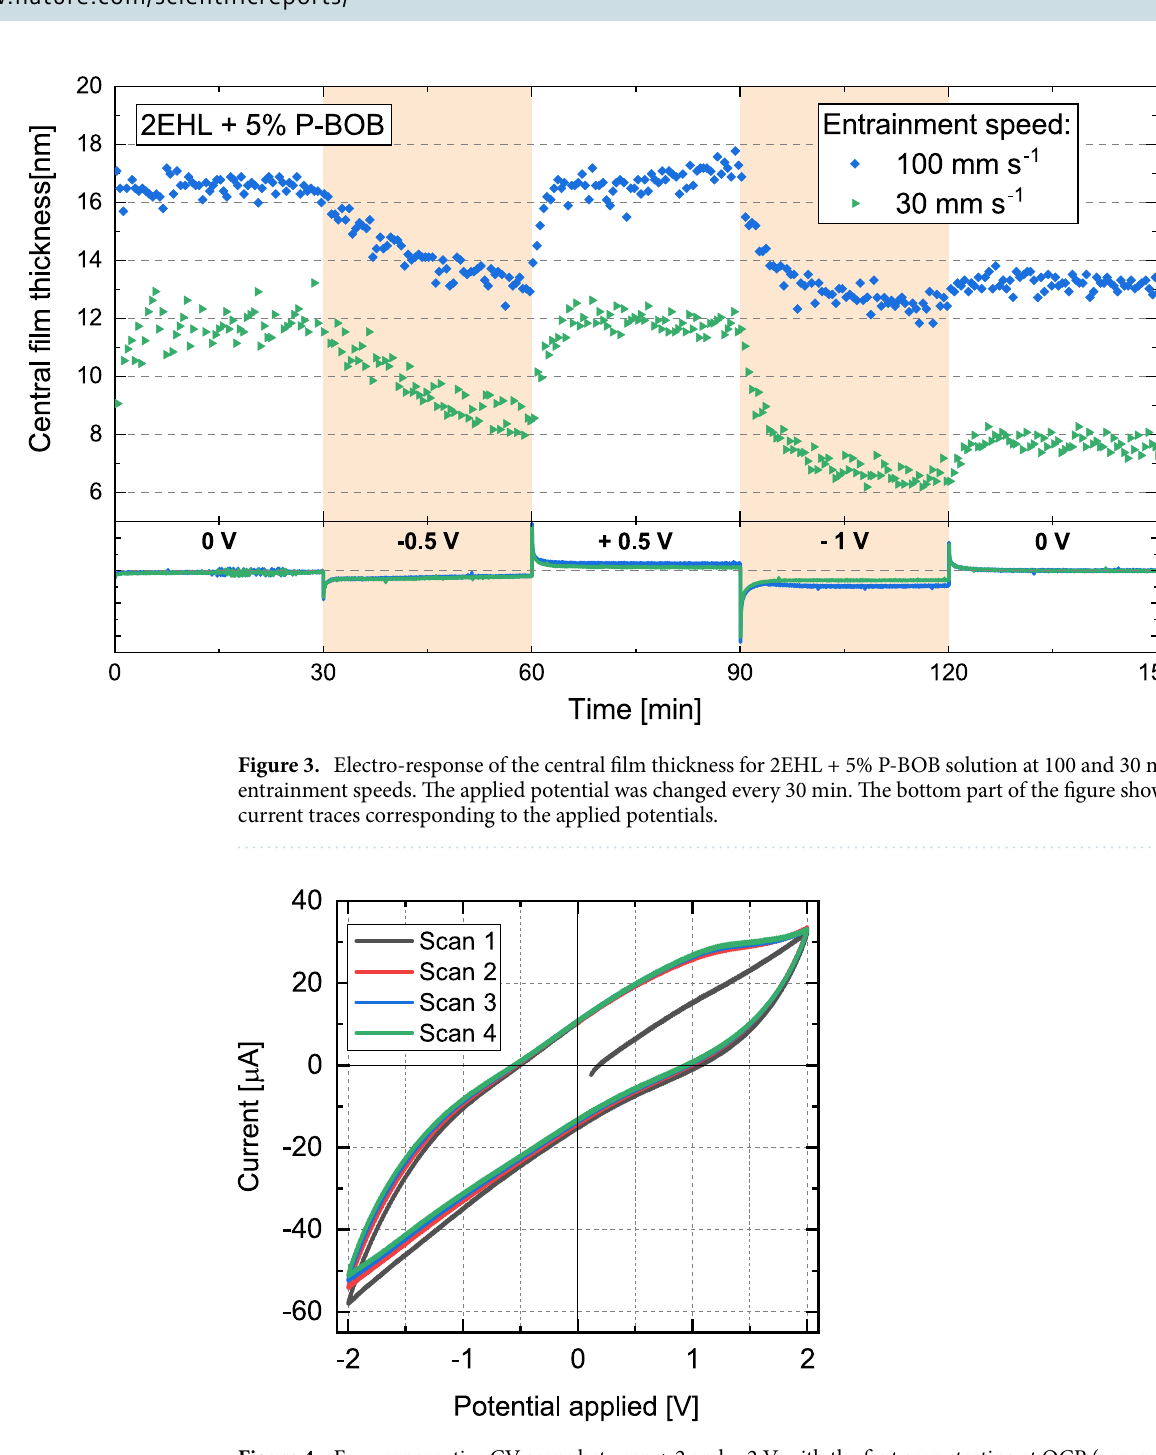
Figure 4. Four consecutive CV scans between + 2 and − 2 V, with the first scan starting at OCP (around + 0.1 V), for 2EHL + 5% P-BOB